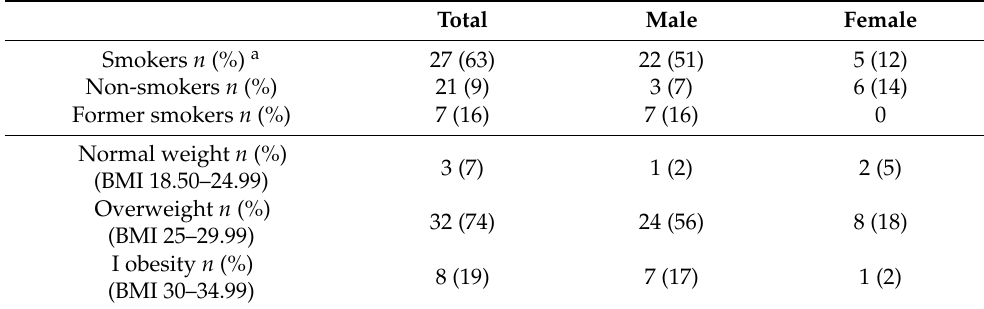
Table 2. DFUs and population lifestyle: smoking habit and BMI.